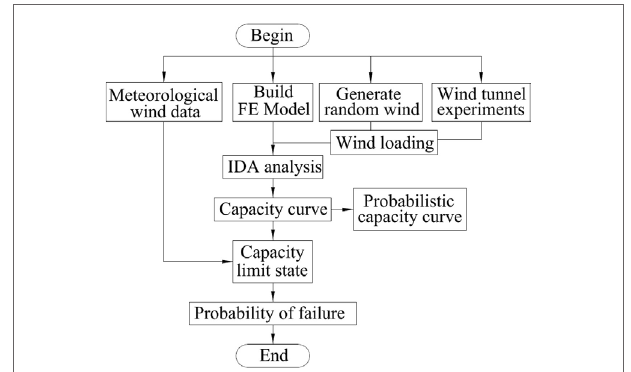
FigUre 15 | Probabilistic capacity assessment approach